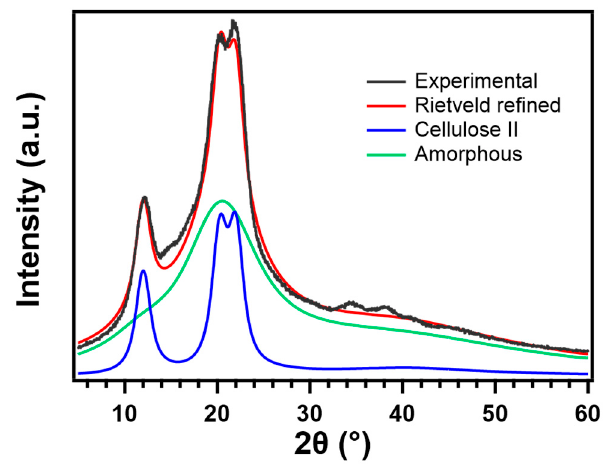
Figure 5. Measurement of the diffractogram performed on RC film prepared from MCC through coagulation with ethanol (black line), calculated total signal (red line), (simulated cellulose II signal (blue line), and simulated amorphous phase (green line). Table 2. Crystal properties of regenerated cellulose film.